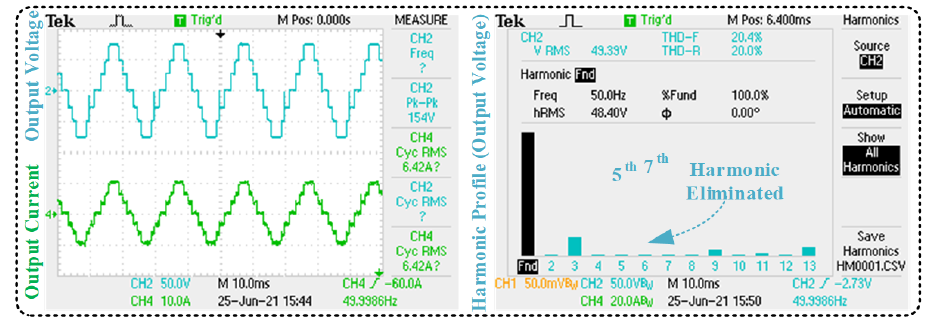
Figure 25. Outputs and harmonic profile of seven-levels MLI.